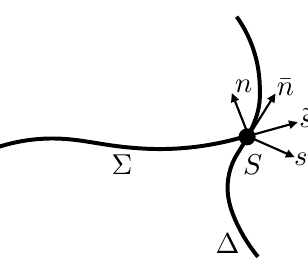
like Cauchy surface Σ at a 2-sphere S .